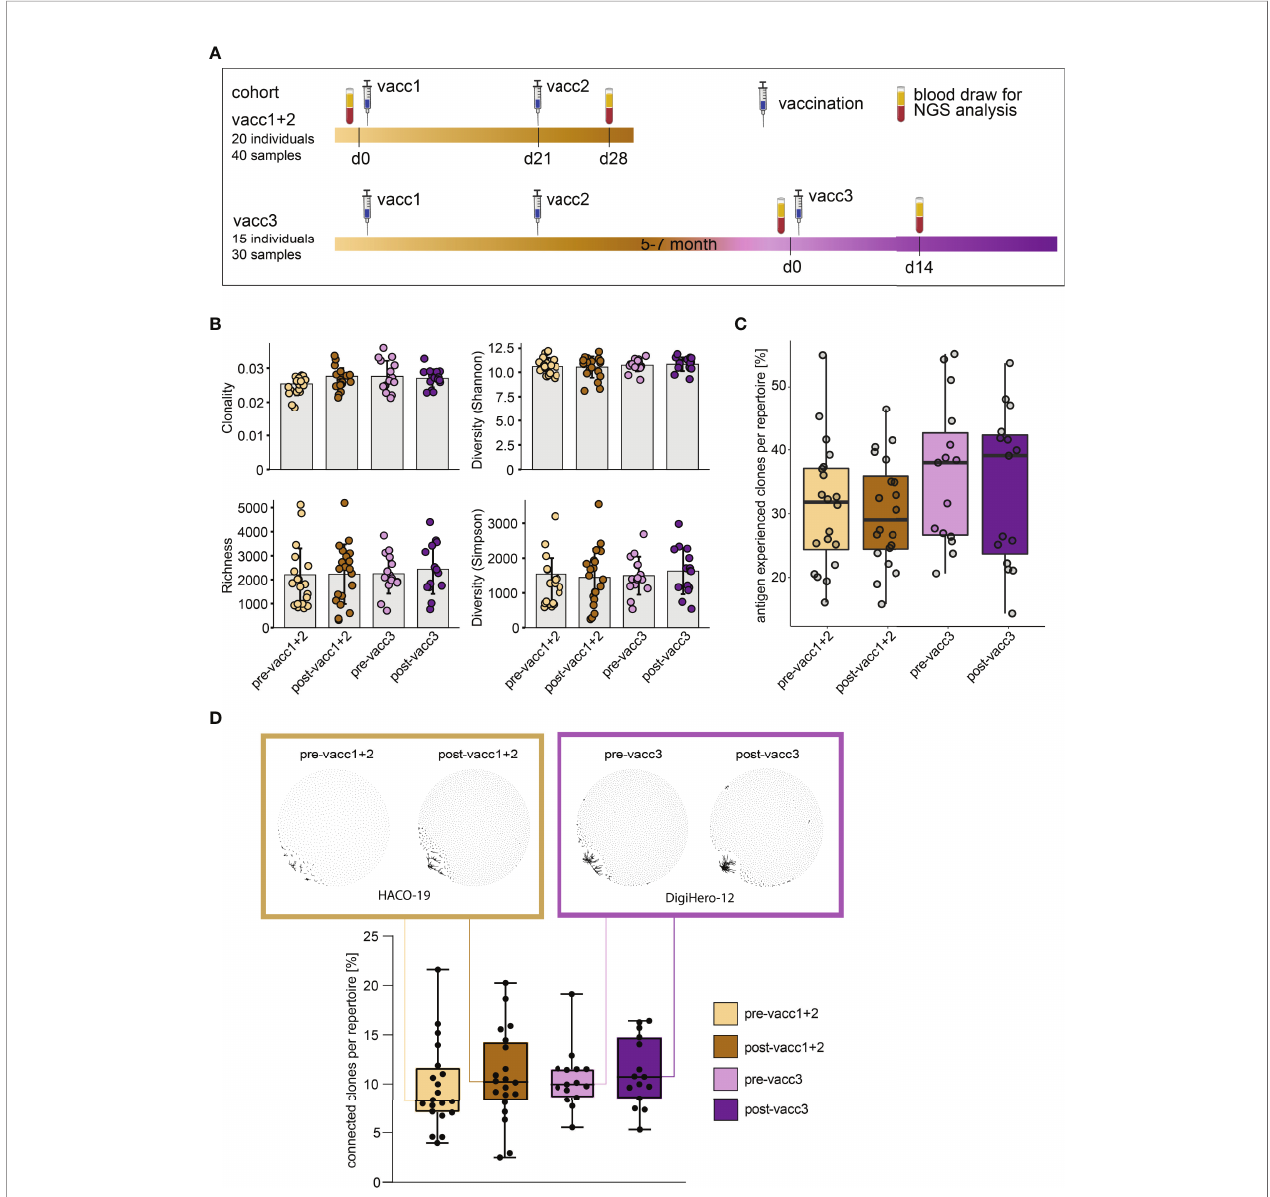
FIGURE 3 | Matched pre- and post-SARS-CoV-2 vaccination blood sampling and global B cell repertoire analysis. (A) Vaccination and blood sampling scheme. (B) Broad B cell repertoire metrics. Bars indicate mean ± standard deviation. (C) Percentage of antigen experienced clones with somatic hypermutation (<98% identity to germline) per B cell repertoire. Box and whiskers plot are shown in the style of Tukey. (D) Quantitative connectivity analysis of B cell clones per repertoire. A clone is de fi ned as a unique CDR3aa sequence. Clones are connected if they have a Levenshtein distance of ≤ 3 are connected. Boxes outline 25 th to 75 th percentile with a line at the median and whiskers from minimum to maximum. Petri dish plots of two representative pre-/post vaccination B cell repertoires are shown in brown and violet boxes on top (patients HACO-19 and DigiHero-12). Each dot in the petri dish plot represents one